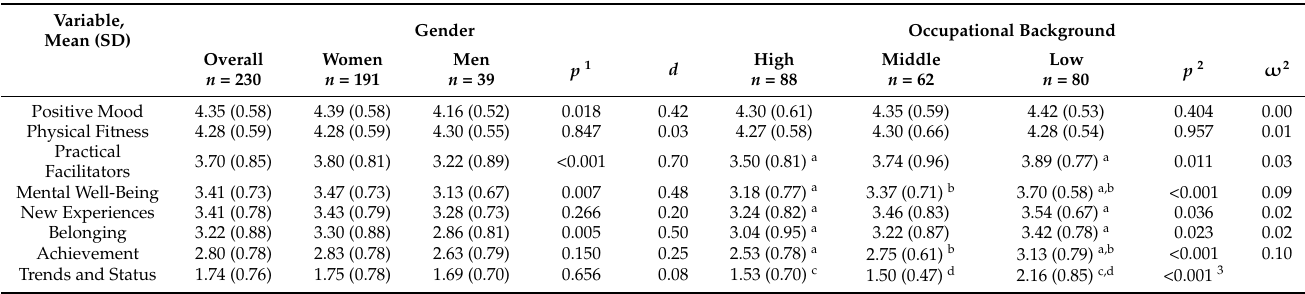
Table 3. Means and standard deviations of the importance of physical activity meaning dimensions (range 1–5) across gender and occupational background ranked by their overall importance with p -values and effect size (d, ω 2